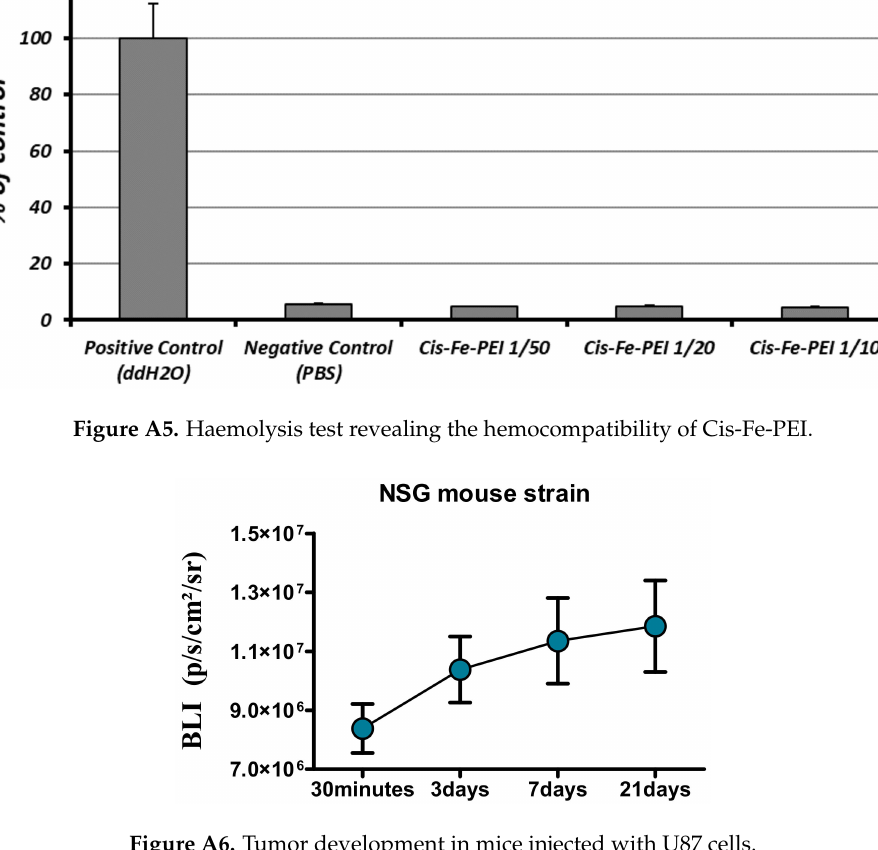
Figure A6. Tumor development in mice injected with U87 cells. Table A1. Thermal properties of Fe-PEI nanostructured